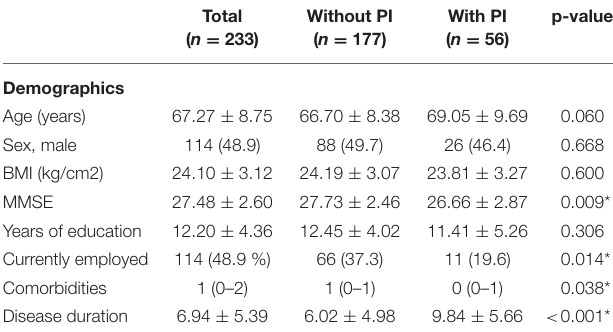
TABLE 1 | Demographics and clinical characteristics of